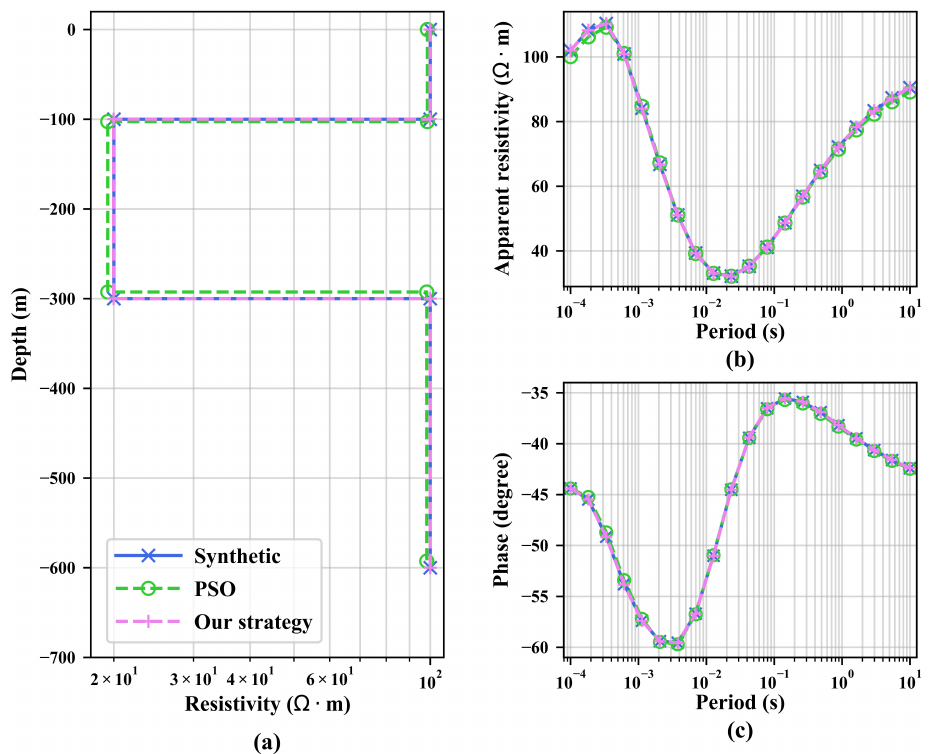
Figure 3. The three-layer geoelectric model and its MT response predicted by traditional PSO and by our strategy. ( a – c ) represent the geoelectric model, apparent resistivity responses and represent phase responses, respectively. The blue lines represent the supposed three-layer geoelectric model and its MT responses. The green lines represent the geoelectric model predicted by the traditional PSO and its MT responses. The purple lines represent the geoelectric model predicted by our strategy and its MT